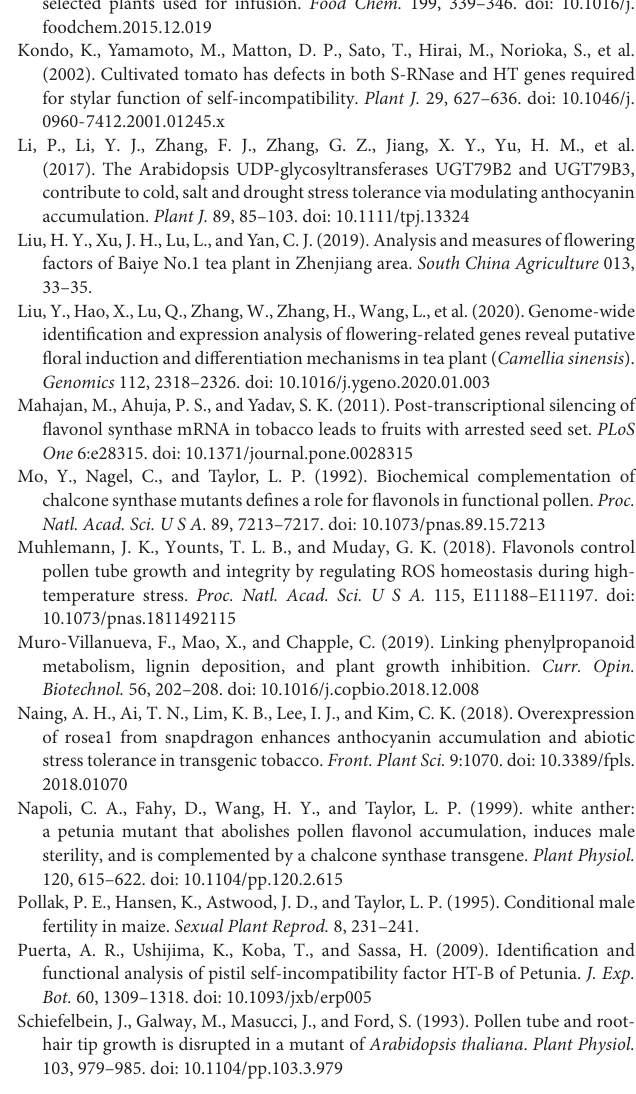
Supplementary Figure 1 | Verification of the relative expression levels of genes by qRT-PCR. Expression patterns of parts of structural genes in S1, S3, S5 flowers involved in phenylpropanoid and flavonoid pathways by qRT-PCR, including (A) C4Ha, (B) 4CLb, (C) CHIc, (D) F3Ha, (E) F3 (cid:48) H, (F) FLSb, (G) LARc, (H) ANRa, and (I)